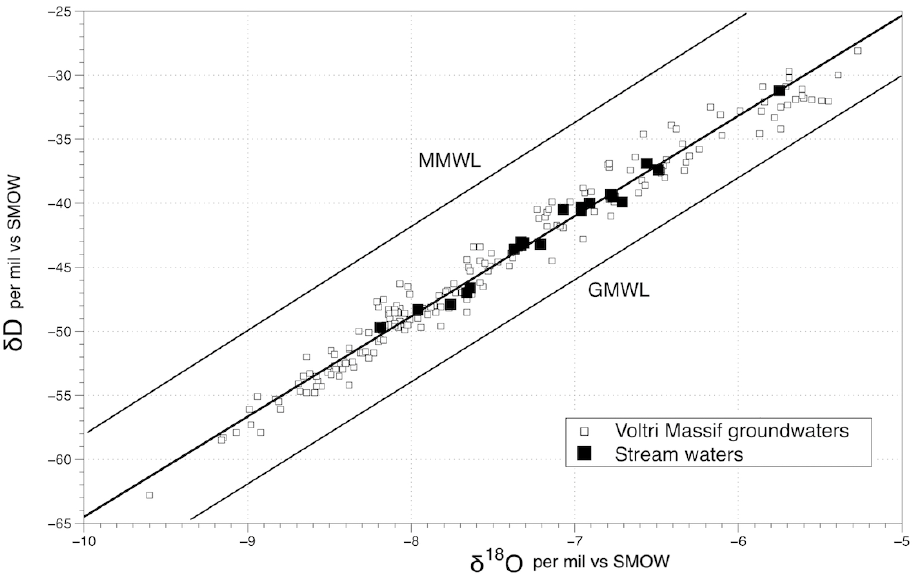
Figure 3. δ D vs. δ 18 O diagram. The stream waters are compared to the global meteoric water line ( δ D = 8 δ 18 O + 10 [68]) and to the Mediterranean meteoric water line ( δ D = 8 δ 18 O + 22 [69]). In the same diagram are reported also the groundwaters of the Voltri Massif [70].